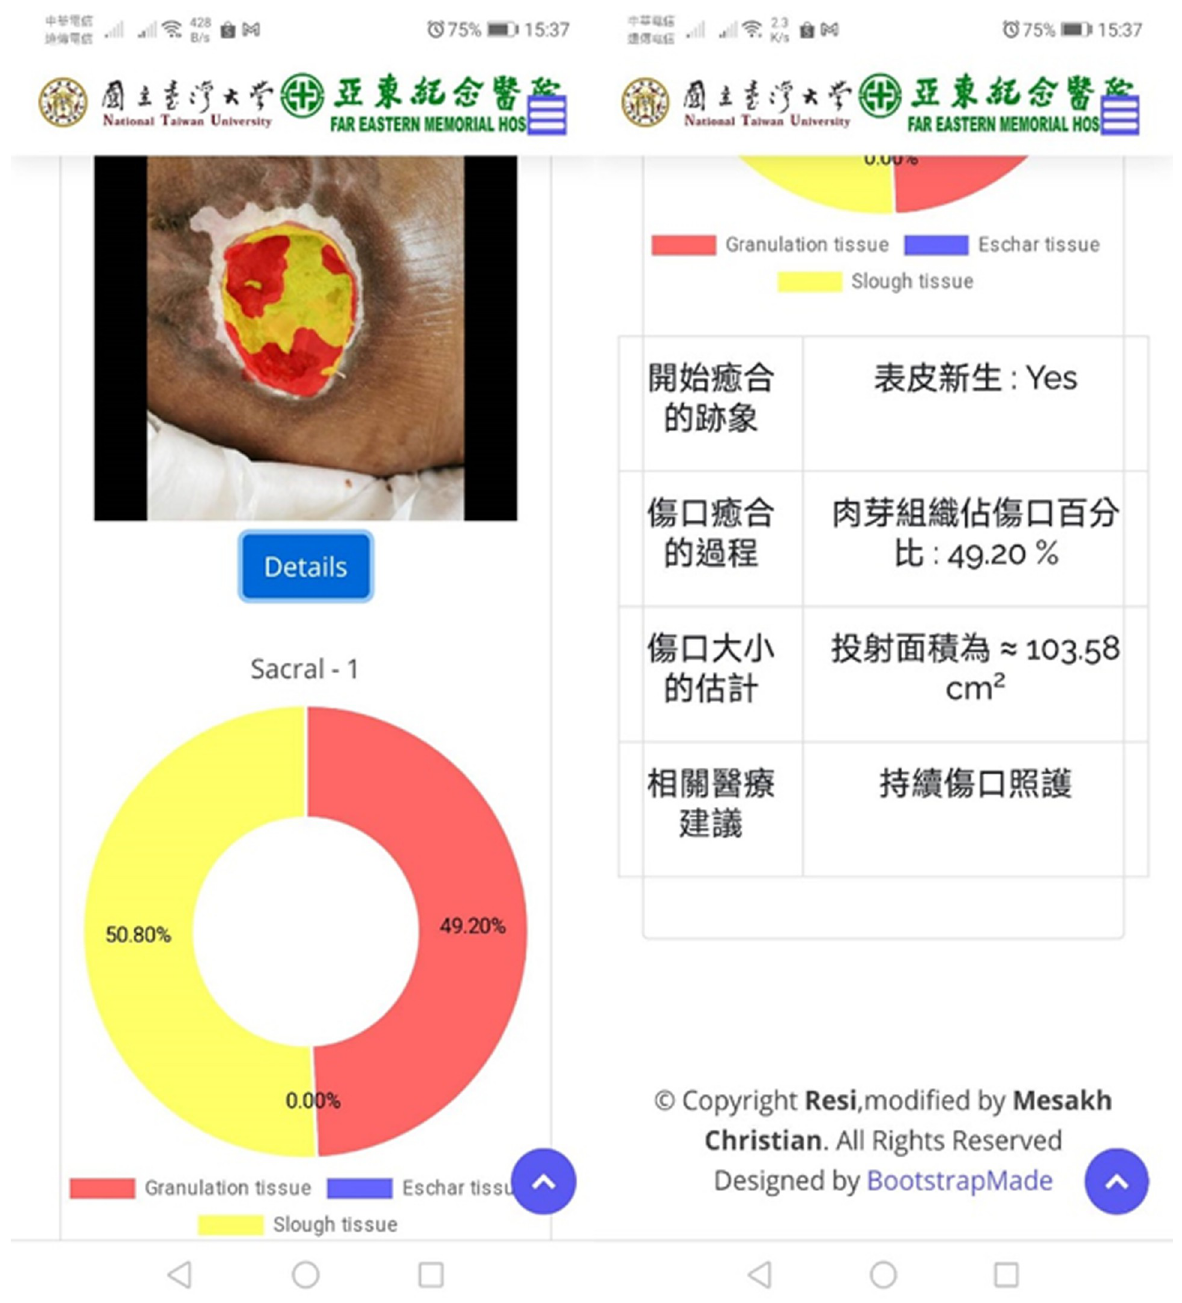
Fig 8. The print-screen images of our automatic diagnosis server. Our medical staffs can upload images and clinical data via cellphones. https://doi.org/10.1371/journal.pone.0264139.g008 tumor contour came from the agreement of multiple experts (relative ground truth). However, the inter-rater agreement of such experts ranges from 50 to 90% depending on the tasks and image modalities [42]. To increase agreement, algorithms or models are used to define mean- ingful regions for medical experts. Radiation experts need only to fine-tune computer-gener- ated borders rather than to hand-draw them on their own. The models are usually trained from a small, but highly reliable labeled dataset consisting of textbook-like medical images